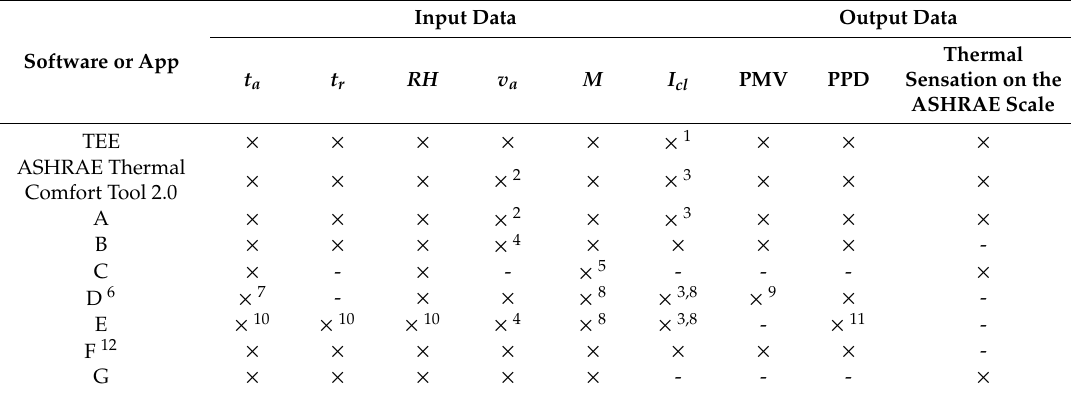
Table 5. Input and output data for software and apps used for comparisons. ( × ) Included; (-) not included. 1 Input value for clothing is the resultant clothing insulation I cl,r . 2 Input value is the air speed. 3 Input value is a “generic” clothing level or value. 4 Input value is the relative air velocity, v ar